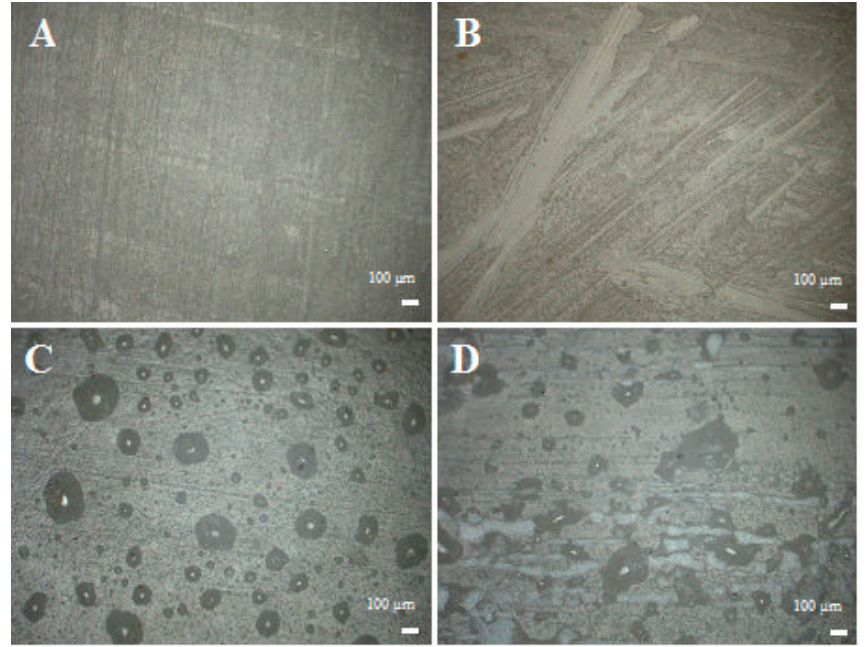
Figure 7. Surface of the samples: lower part. ( A )—glass, degassed; ( B )—glass, non-degassed; ( C )—silicone, degassed; ( D )—silicone, non-degassed.